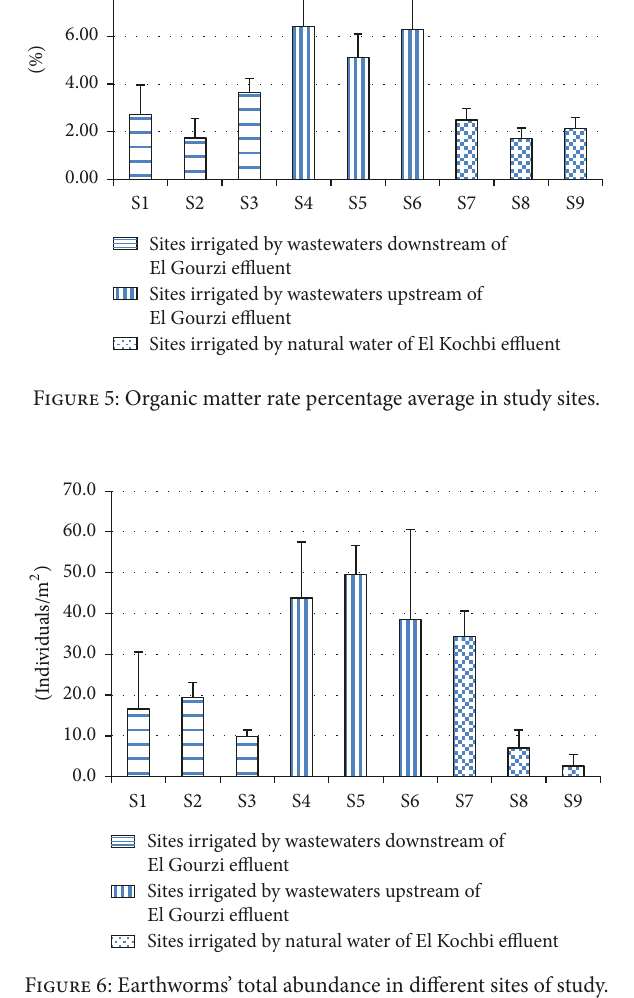
Figure 6: Earthworms’ total abundance in different sites of study.